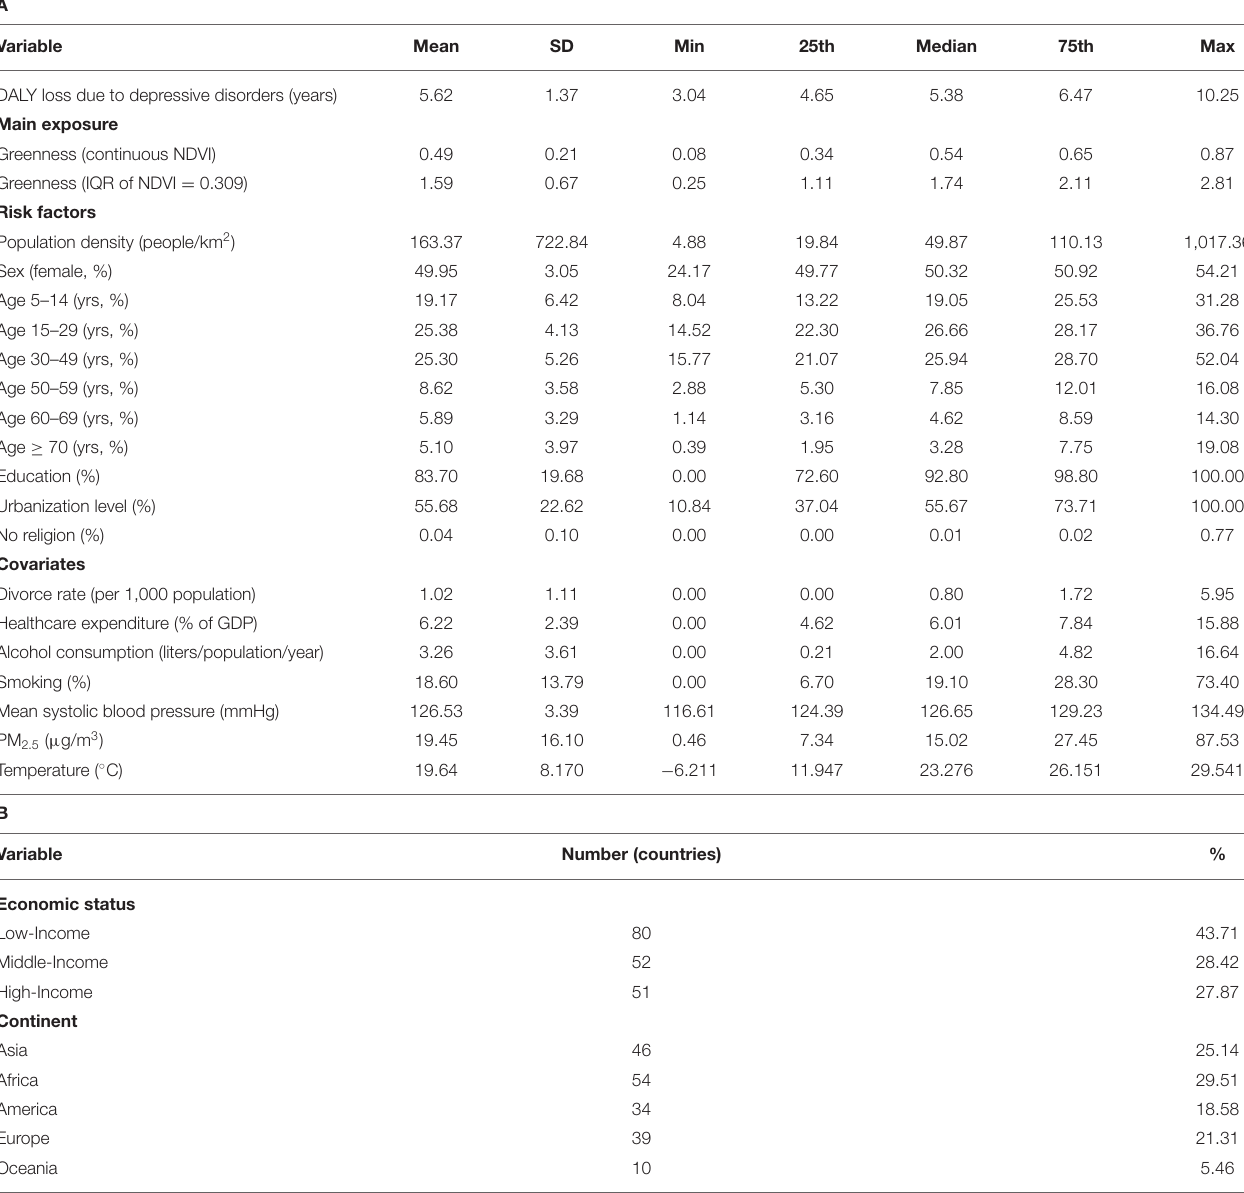
TABLE 1 | Descriptive statistics of variables examined in this study, (A) continuous variables and (B) categorical